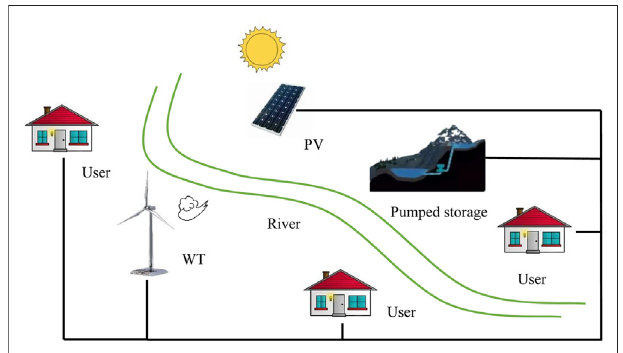
FIGURE 1 | Diagram of distribution network integrated planning